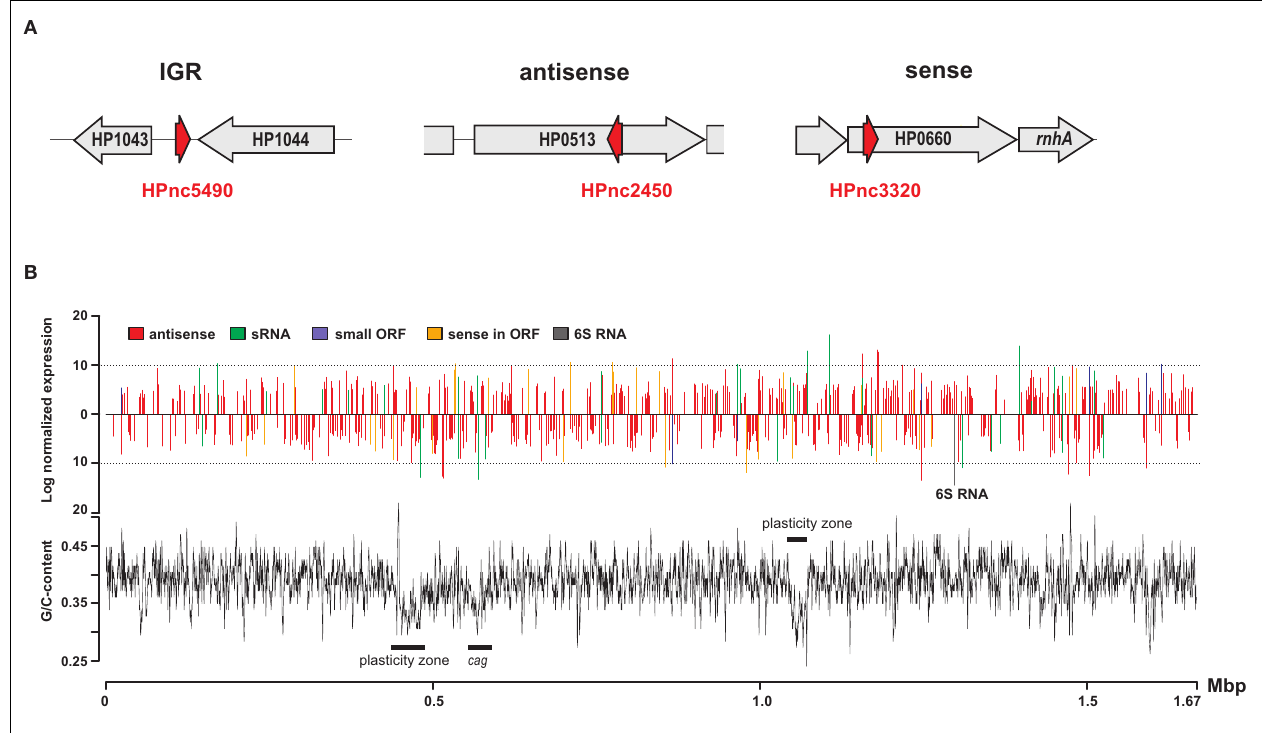
types of sRNA candidates is given as log2 values of read numbers of all sequenced libraries (upper part) and plotted together with local G/C-content (lower part) across the H. pylori strain 26695 genome. One of the most abundant sRNAs is the previously missed 6S RNA homolog from the Epsilon subdivision (gray bar).The Figure was adapted from Sharma et al.